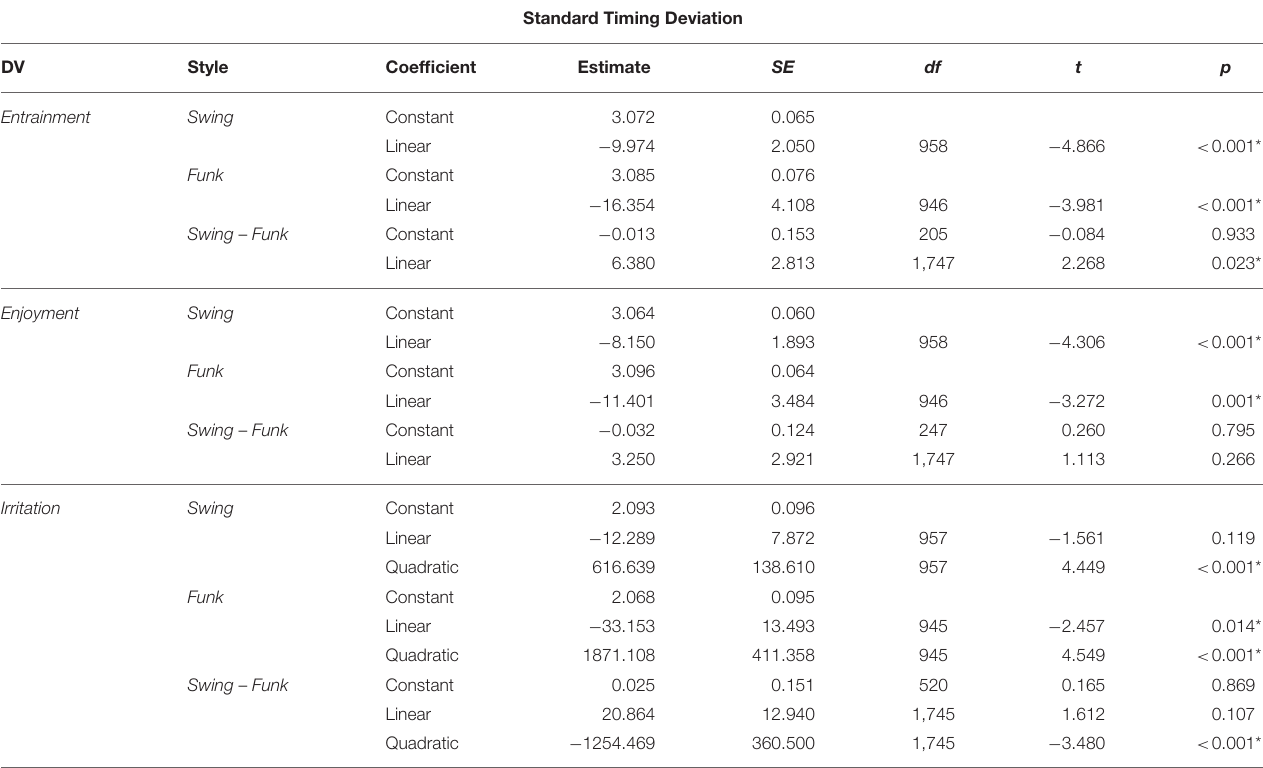
TABLE 2 | Regression models for the relationship between Standard Timing Deviation and Entrainment , Enjoyment , and Irritation for Swing , Funk , and the difference between Swing and Funk